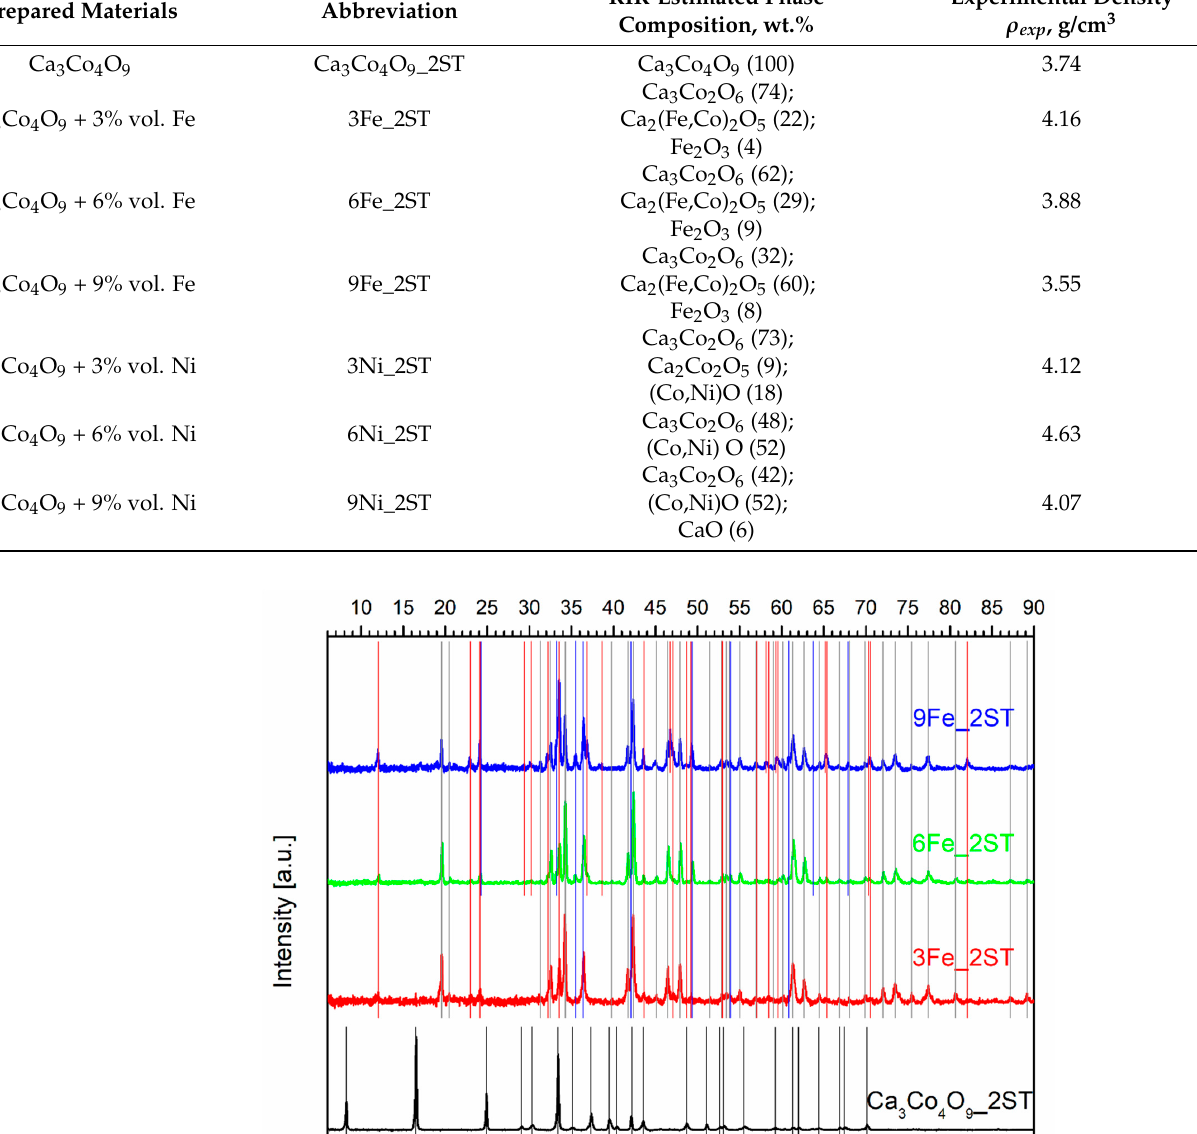
Figure 7. Normalized XRD patterns of the 2ST sintered reference matrix and Ni added samples. The vertical lines of different colors mark the main identified phases. The thermoelectric Ca 3 Co 4 O 9 phase could not be detected in neither the 2ST sintered Fe and Ni added samples, where the main phases have been found to be Ca 3 Co 2 O 6 and brownmillerite Ca 2 (Co,Fe) 2 O 5 [67], for the Fe additions, and Ca 3 Co 2 O 6 and (Co,Ni)O, for